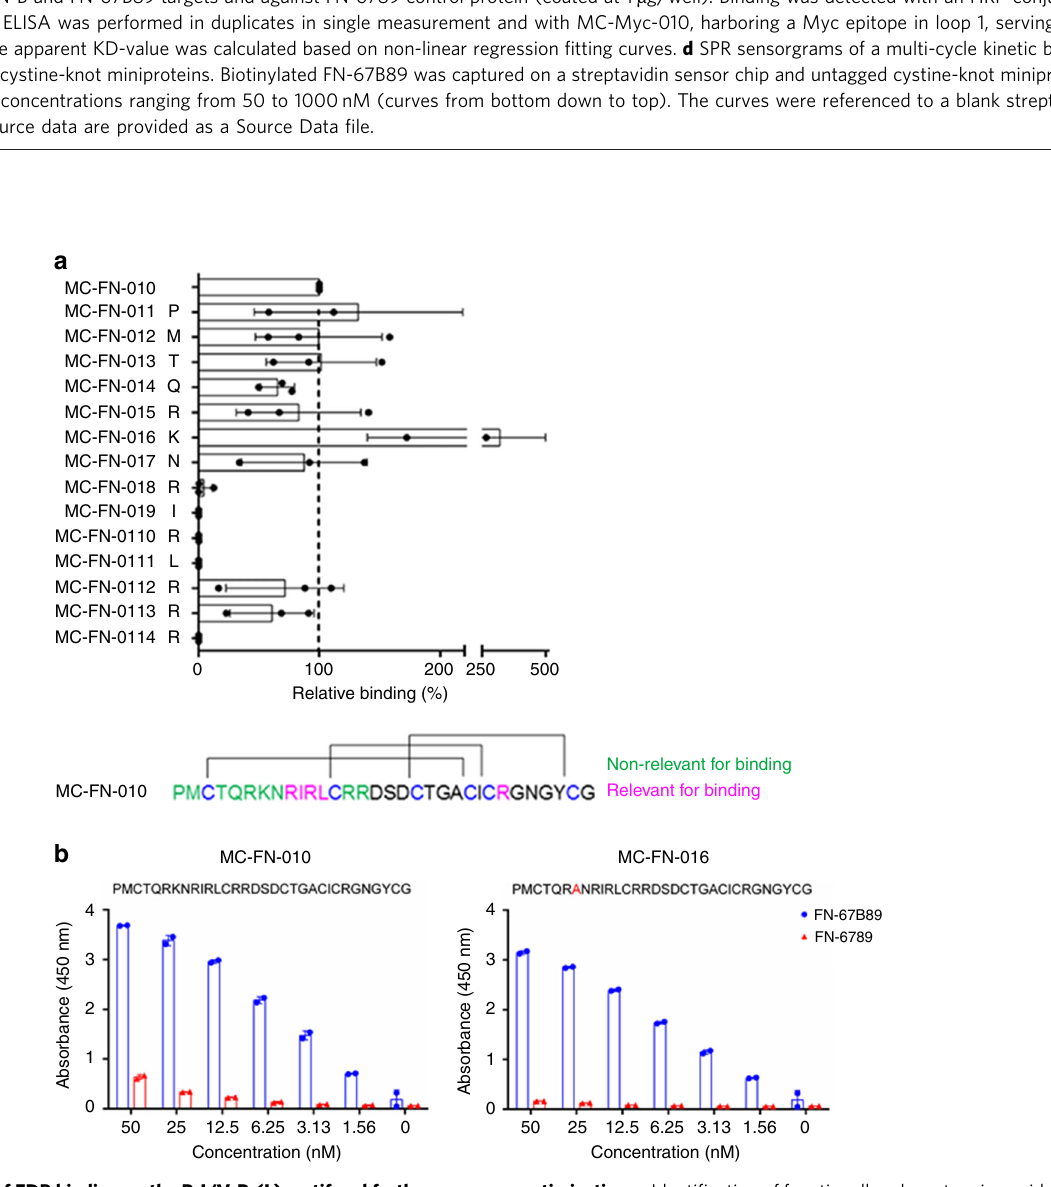
Fig. 3 Dependency of EDB binding on the R-I/V-R-(L) motif and further sequence optimization. a Identi fi cation of functionally relevant amino acids in the MC-FN-010 sequence by alanine scanning mutagenesis. Trx-cystine-knot miniproteins (parental MC-FN-010 and alanine scanning variants) were incubated with pre-coated human FN-B. Binding was detected with HRP-conjugated anti-S-tag antibody. Relative binding of each variant was calculated by comparing the respective apparent binding constant to parental MC-FN-010. Error bars represent mean ± SD of three independent duplicate measurements. EDB binding relevant amino acid residues of parental MC-FN-010. Disul fi de bonds (brackets) between cysteine residues (blue), residues relevant (magenta), or at best marginally relevant (green) for target binding are indicated. b ELISA-based binding analysis of MC-FN-010 and MC-FN-016 to human FN-67B89 and FN-6789 (1 µ g/well). Trx-cystine-knot miniproteins were applied at different concentrations in duplicates and binding was detected with HRP-conjugated anti-S-tag antibody. Data shown as mean ± SD. Source data are provided as a Source Data fi